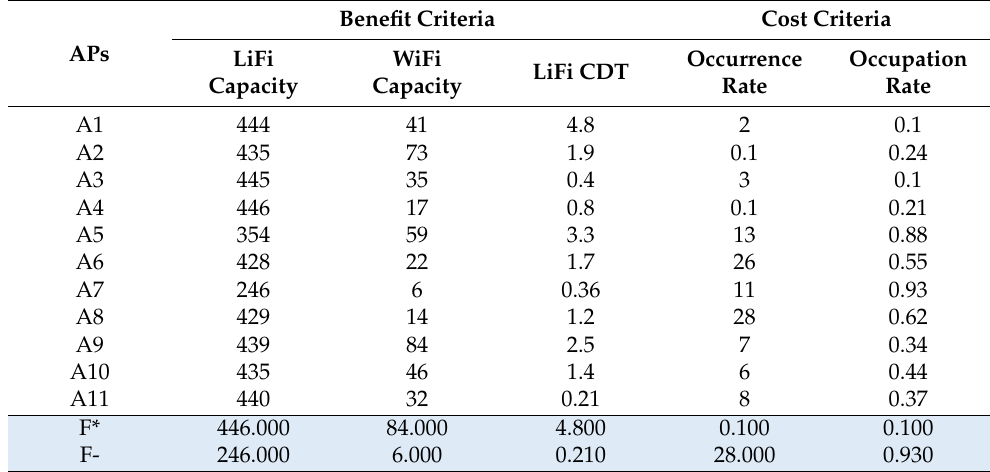
Table 20. VIKOR cost and benefit criteria results.